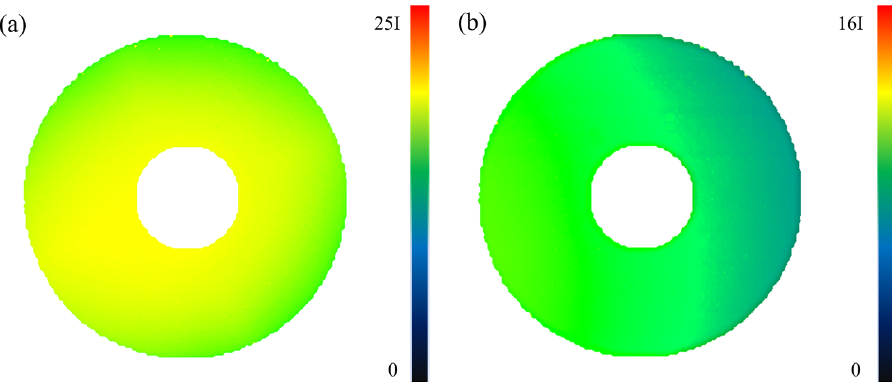
Figure 11. Radiation intensity distribution of sandwich transducer end face: ( a ) vibration intensity cloud diagram of transducer end under first order natural frequency; ( b ) Vibration intensity cloud diagram of transducer end under second order natural frequency.